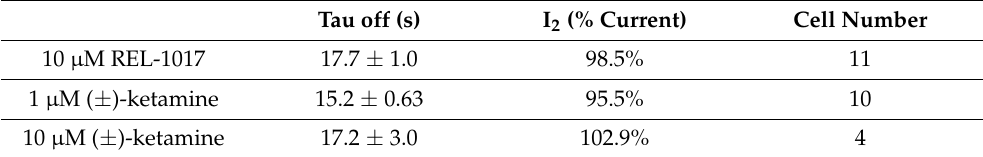
Table 5. Offset kinetic parameters.